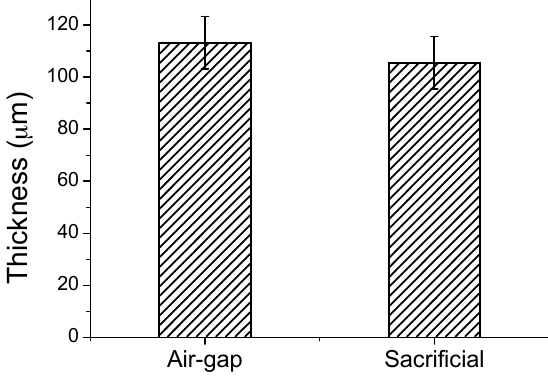
Figure 8. Comparison of the thicknesses of the air-gap and the sacrificial layer.